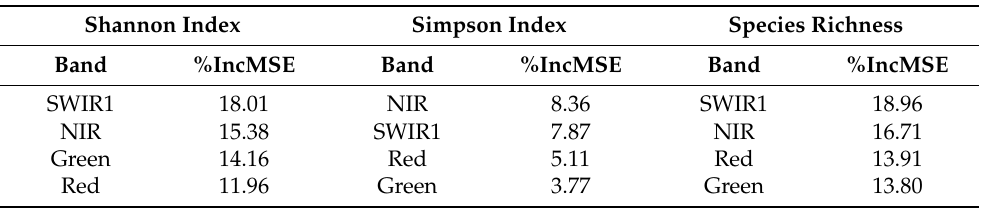
Table 8. Variable importance ranking for the Landsat 8 image model under the Shannon Index, Simpson Index and the Species